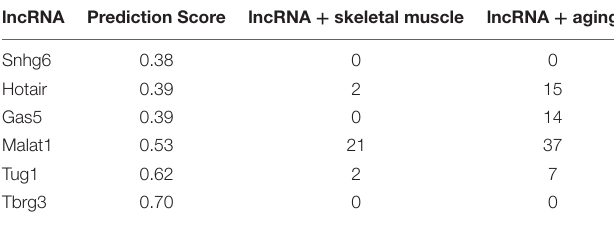
TABLE 1 | DIANA prediction scores for mmu-miR-34a-5p lncRNA binding and PubMed searches for various search terms and